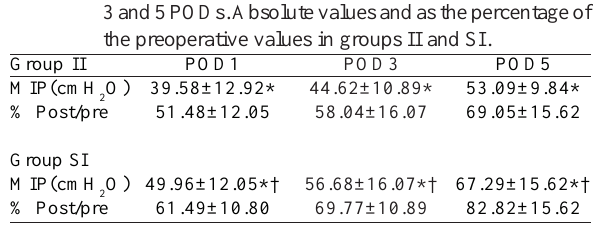
Table 2. Maximal inspiratory pressure values are presented in 1, 3 and 5 PODs. Absolute values and as the percentage of the preoperative values in groups II and SI.